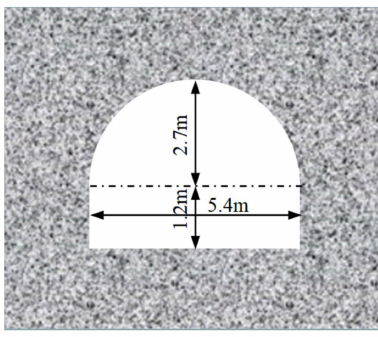
Figure 3. Schematic diagram of roadway cross section